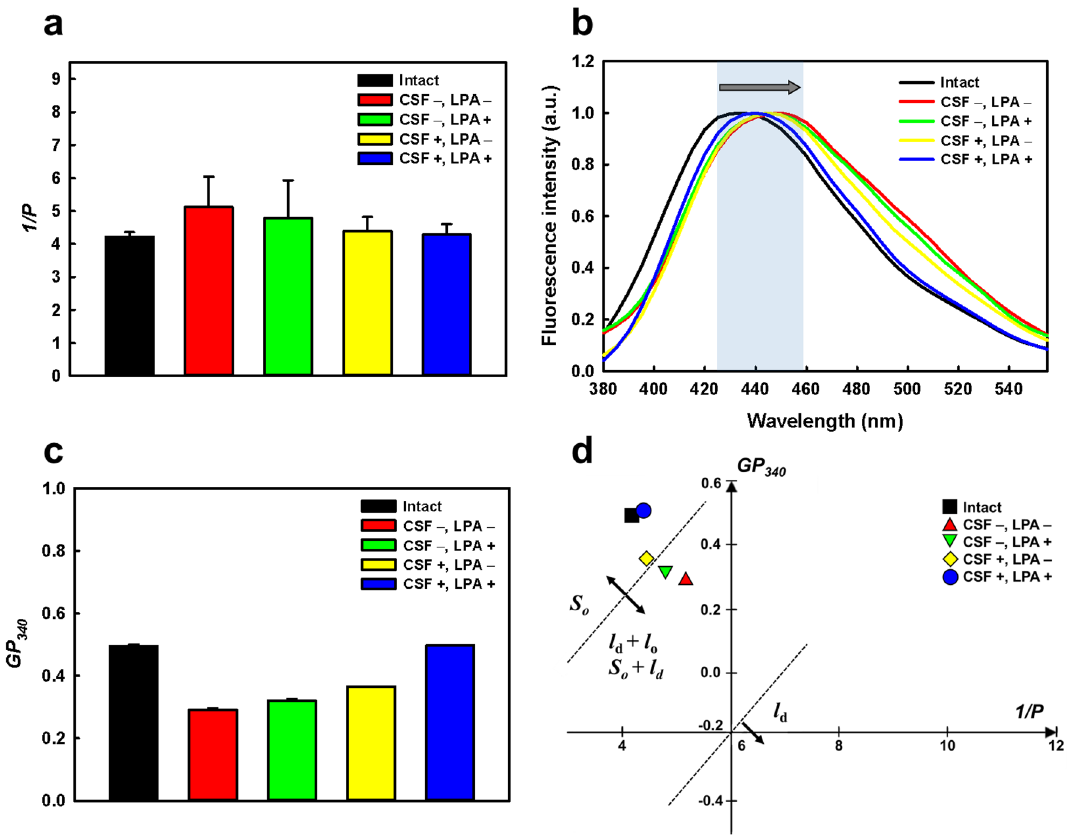
Figure 4. Membrane fluidity and polarity of intact lipid nanovesicles and lyophilized lipid nanovesicles with different freezing conditions, after rehydration. ( a ) The membrane fluidity ( 1/P ) values of the lipid nanovesicles measured using 1,6-diphenyl-1,3,5-hexatriene fluorescent dye. ( b ) Fluorescence spectra of Laurdan intensity and ( c ) the membrane polarity ( GP 340 ) values of the lipid nanovesicles. Total concentrations of lipid and Laurdan in the test solution were 200 and 1 μM, respectively. ( d ) Cartesian diagram of the lipid nanovesicles. The x and y axes indicate 1/P and GP 340 values,